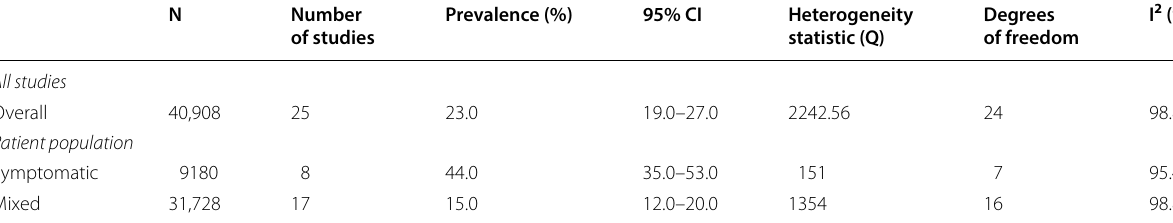
Table 3 Effect of population on prevalence of spider mite sensitivity